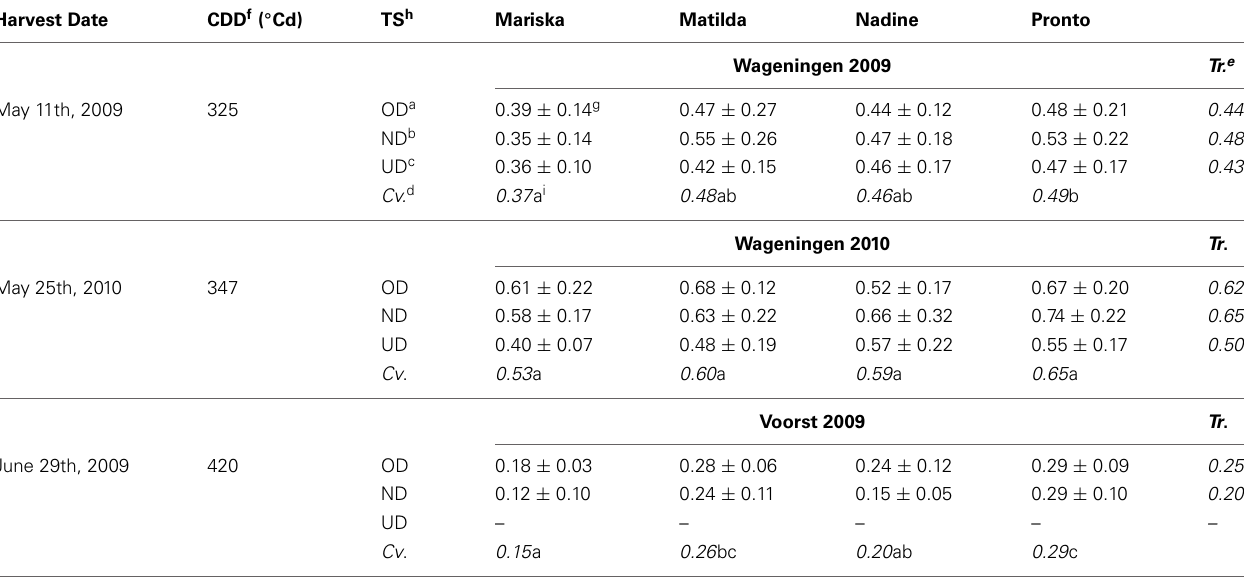
Table 5 | Average estimated root dry weights (g per plant) of the four cultivars at third root sampling, after establishment from three different transplant